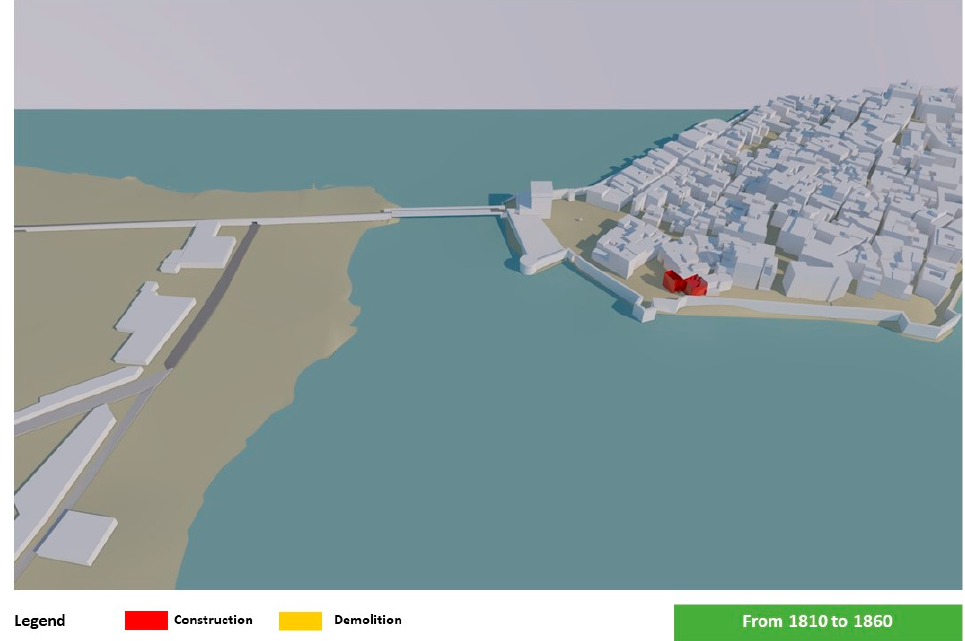
Figure A1. Three-dimensional model of differences between volumes built or demolished—from 1810 to 1860.